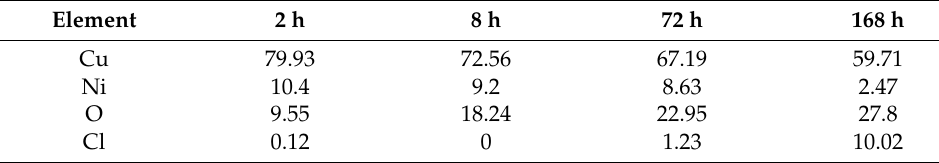
Table 5. Contents of different elements of the surface film by EDS (wt%).